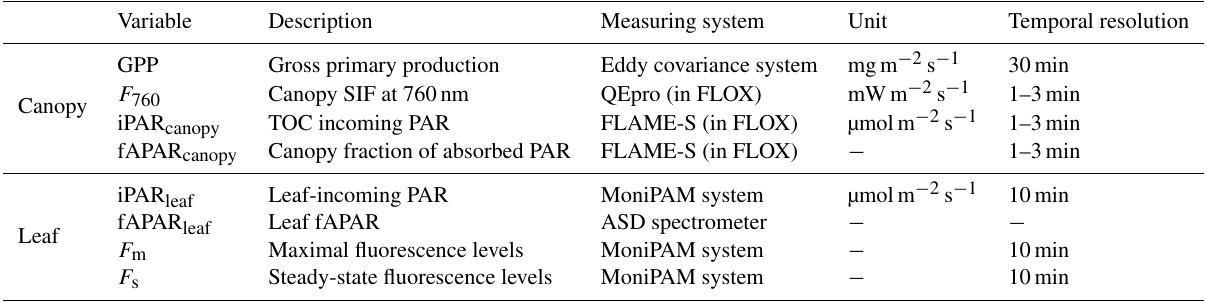
Table 1. Summary of the main canopy and leaf field measurements used in the analyses. Variable Description Measuring system Unit Temporal resolution